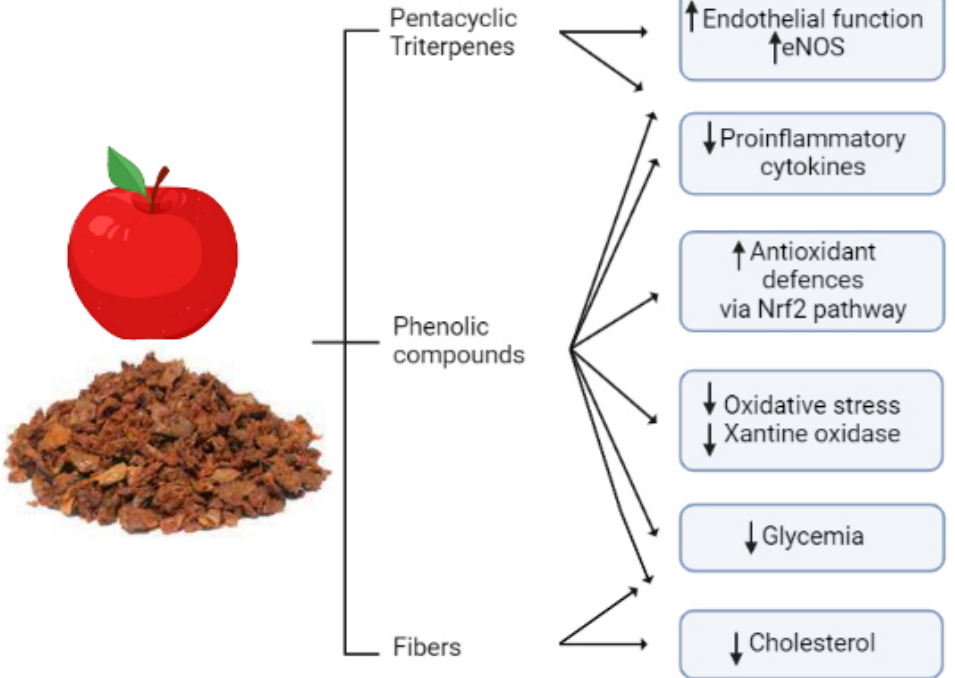
Figure 2. Apple pomace classes of bioactive compounds and their cardio- and vasculoprotective actions. Apple pomace contains fibers that mainly provide cholesterol-lowering effects, but it also contains bioactive compounds such as phenols and triterpenes that provide multiple effects positively affecting the cardiovascular system, such as improvement in endothelial function and antioxidant effect, reduction in proinflammatory cytokines and oxidative stress, and a hypoglycemic effect. Overall, thanks to its composition, apple pomace exerts pleiotropic cardio- and vasculoprotective effects by targeting multiple signaling pathways and risk factors. The figure is original and created with